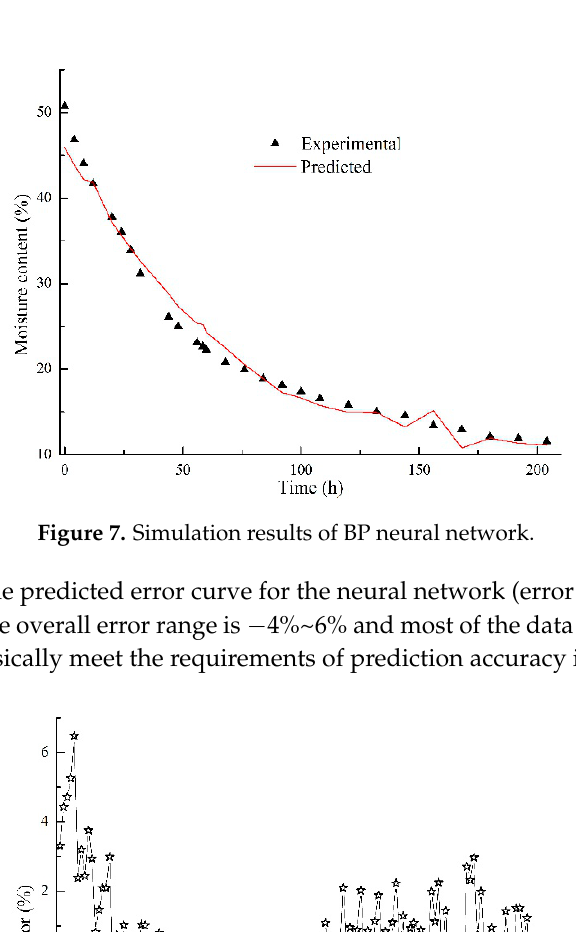
Figure 8. Prediction error of BP neural network.